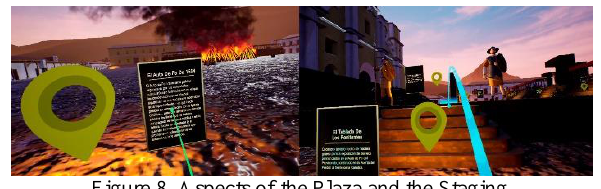
Figure 8. Aspects of the Plaza and the Staging.